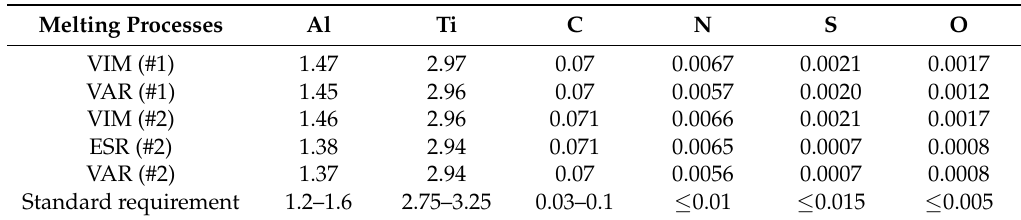
Table 2. Percentage compositions of some elements in superalloy ingots following different smelting processes